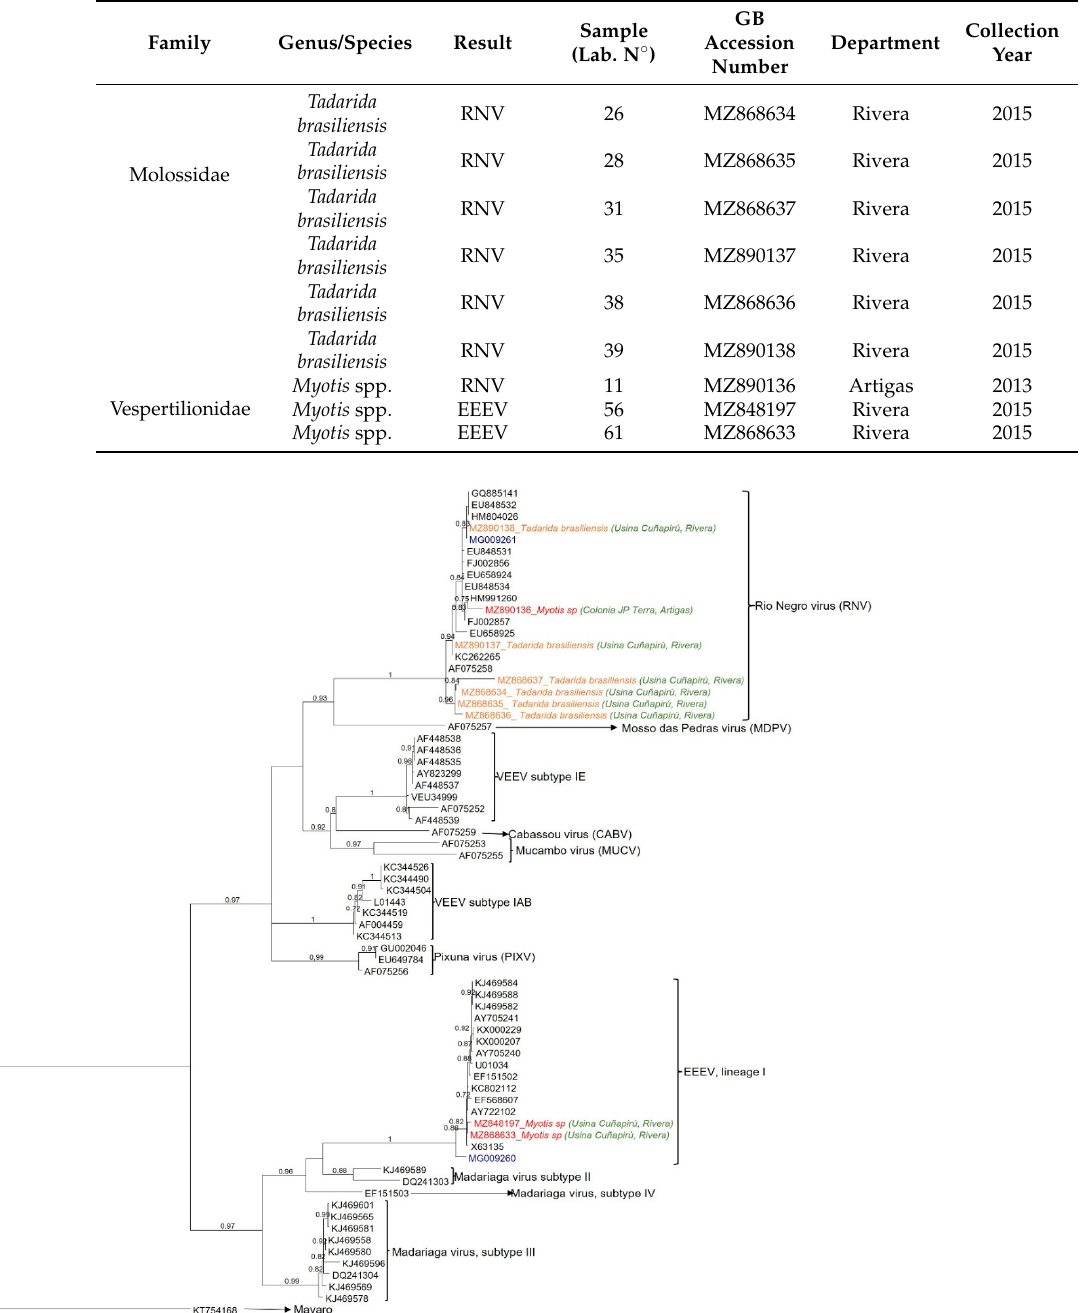
Table 2. Alphavirus results. Bat families and species, GenBank accession numbers for sequences, site, and year of collection.